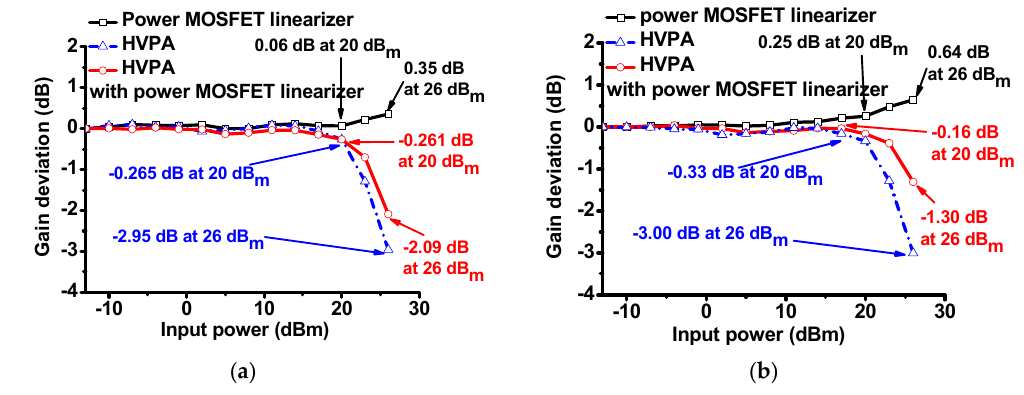
Figure 6. The gain deviation graphs of the power MOSFET linearizer, HVPA, and HVPA with power MOSFET linearizer when ( a ) 70 and ( b ) 80 MHz input power were applied.